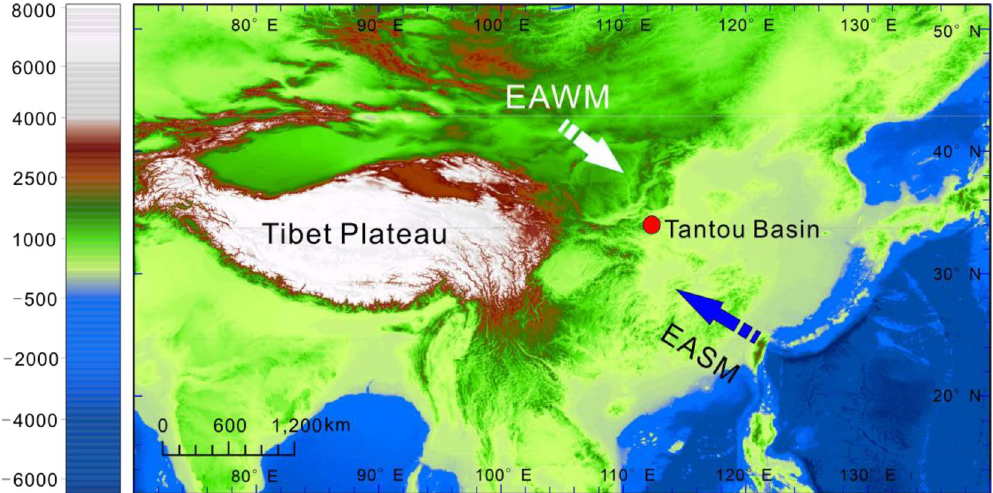
Figure 1. Map showing the study site in the Tantou Basin. ArcMap 10.2 software (http:// www. tuico ol. com/ artic les/ VfaMfy) was used to create this